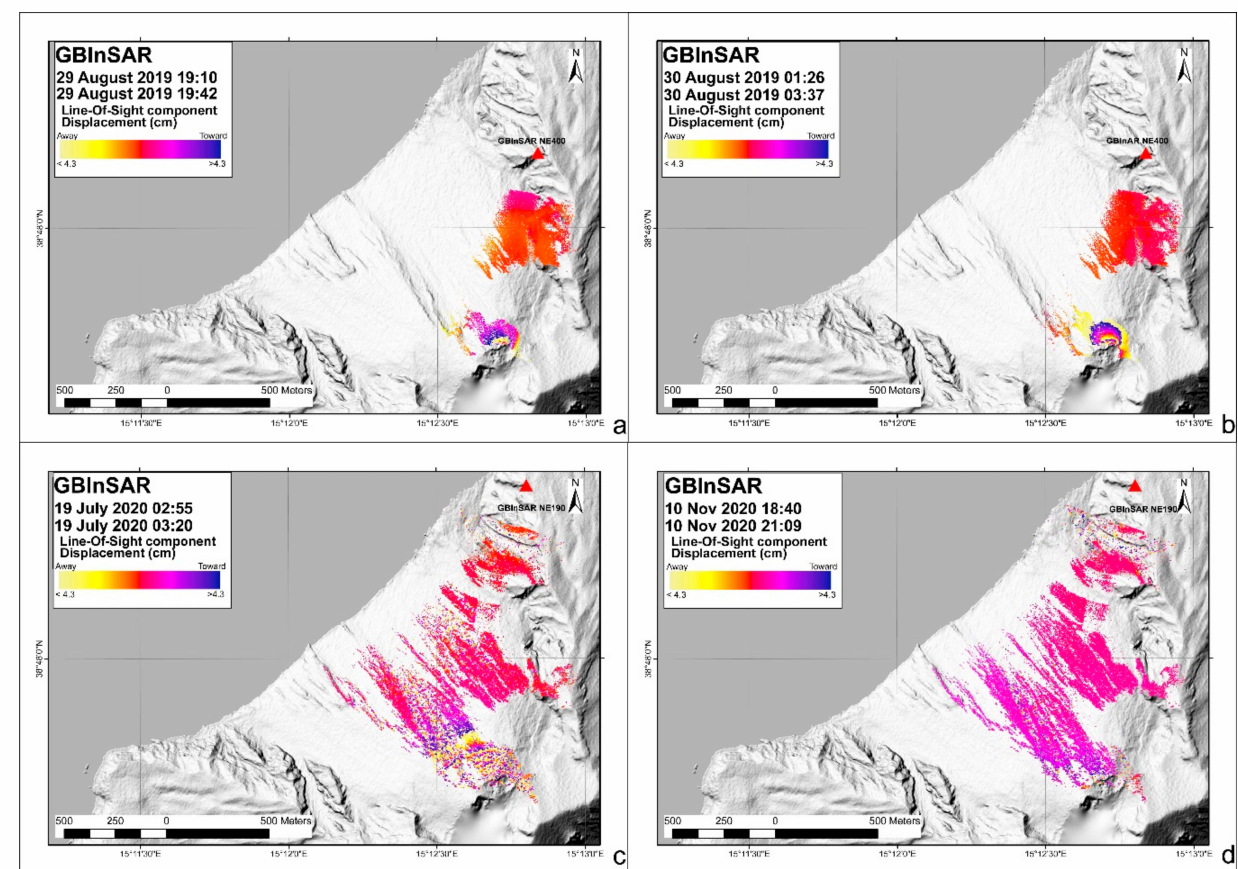
Figure 20. ( a ) 29 August 2019 (19:10-19:42) interferogram generated with GBInSAR NE400 system; ( b ) 30 August 2019 (01:26-03:37) interferogram generated with GBInSAR NE400 system; ( c ) 19 July 2020 (02:55-03:20) interferogram generated with GBInSAR NE190 system; ( d ) 10 November 2020 (18:40-21:09) interferogram generated with GBInSAR NE190